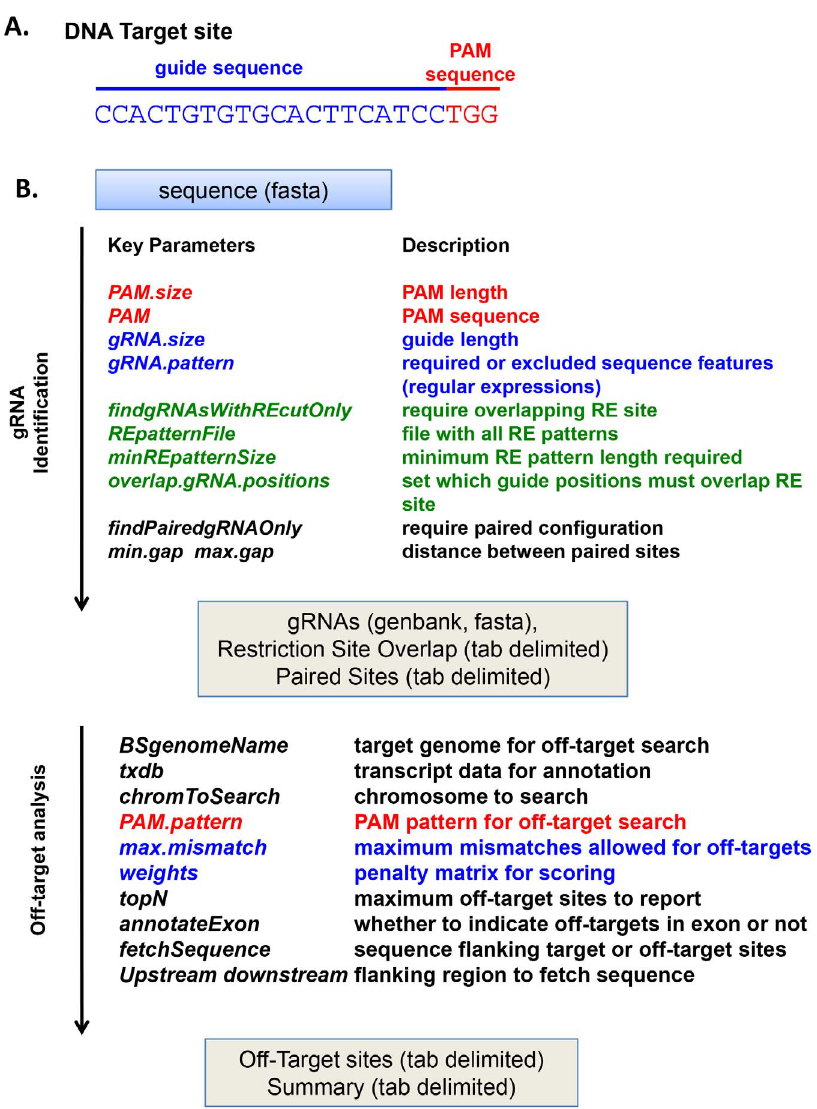
Figure 1. Major parameters to identify gRNA-Cas9 target and off-target sites with the offTargetAnalysis function of CRISPRseek . A. Target sequences for CRISPR-Cas9-derived nucleases are composed of two components, the guide sequence (red) that matches the variable region in the guide RNA and an associated PAM sequence that is recognized by the Cas9 protein. The sequence shown is a possible target sequence for a nuclease based on the S. pyogenes CRISPR-Cas9 system, which has a 20 base pair guide sequence and a PAM sequence of NGG or NAG. B. offTargetAnalysis first identifies candidate guide sequences in an input sequence. Some of the possible parameters to identify these sequences are indicated, including parameters for the guide sequence, the adjacent PAM sequence and other features such as overlapping restriction enzyme sites. Next, potential off-target sites for the identified guide sequences are identified in a specified genome. A variety of parameters can be adjusted to determine the criteria used to identify and score off-target